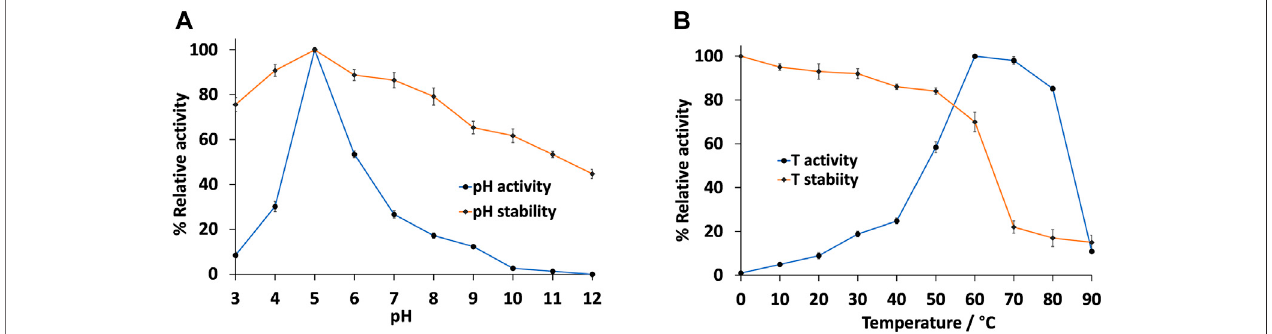
FIGURE 2 | Effect of (A) pH and (B) temperature on the activity and stability of pLac Gy . Unless otherwise stated, assay temperature was 60 ° C. Assay mixture included 0.5 µM pLac Gy , 1 mM ABTS, 50 µM CuCl 2 in 0.04 M Britton-Robinson buffer (pH 5.0). For enzyme stability measurements, residual activity was measured at 60 ° Cinpresence of1 mMABTSand50 μ MCuCl 2 in0.04 MBritton-Robinson buffer (pH5.0) afterpre-incubatingtheenzymeinthetestconditionfor6 h.Theactivityof the enzyme without pre-incubation measured at the pH 5.0 at 60 ° C was set at 100%. All experiments were conducted in triplicates and error bars represent standard deviations.